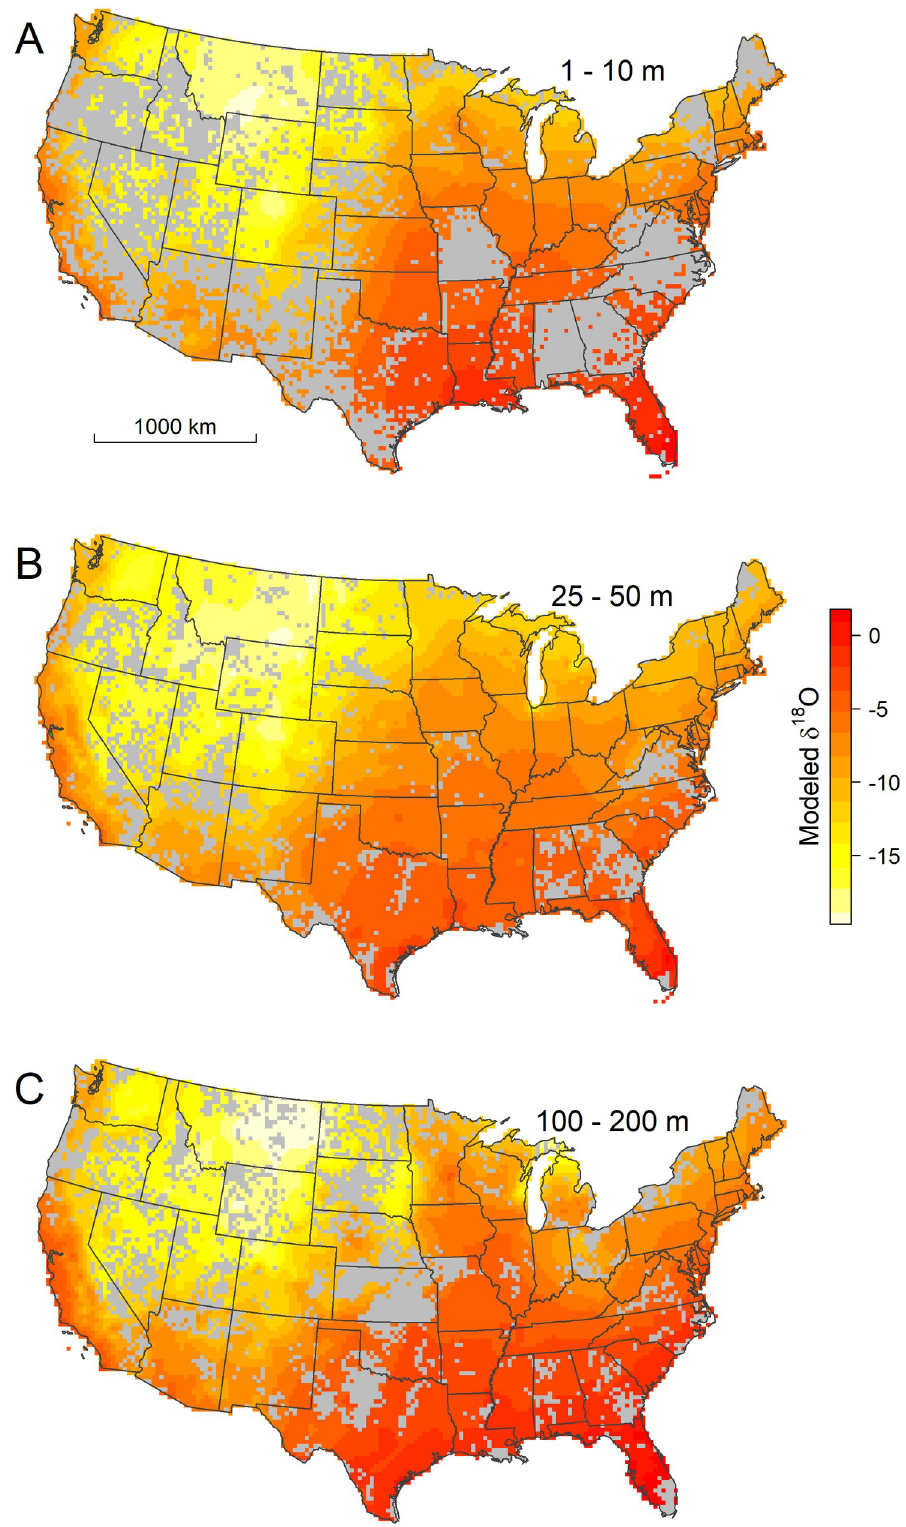
Fig 3. Spatially interpolated δ 18 O values for ground water at shallow (A), intermediate (B), and deep (C) depths. Gray cells contain no wells completed within the mapped depth interval.